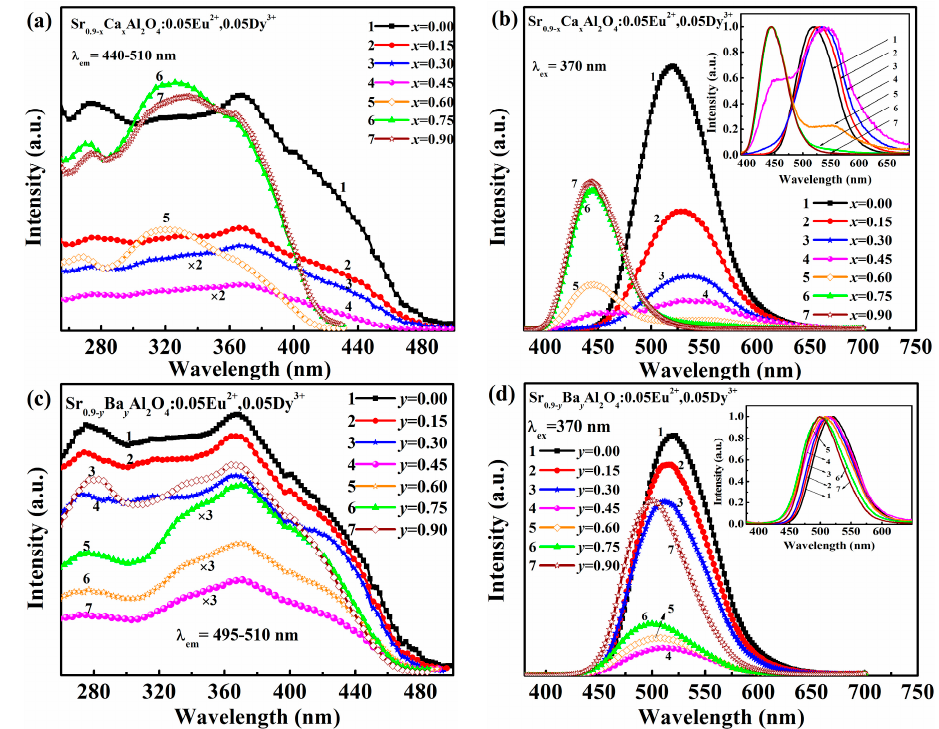
Figure 2. ( a ) Excitation and ( b ) emission spectra of Sr 0.90 − x Ca x Al 2 O 4 :0.05Eu 2+ , 0.05Dy 3+ phosphors with varied x values (Inset is the normalized emission spectra of); ( c ) excitation and ( d ) emission spectra of Sr 0.90 − y Ba y Al 2 O 4 :0.05Eu 2+ , 0.05Dy 3+ phosphors with varied y values (Inset is the normalized emission spectra).